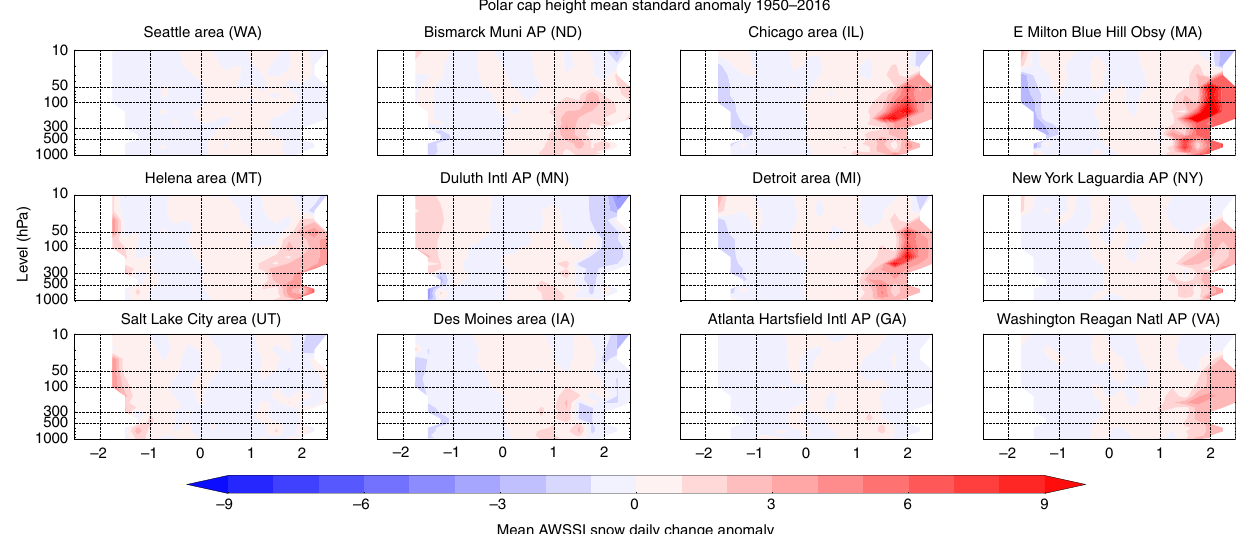
Fig. 4 Warm Arctic related to increased snowfall. Snowfall contribution to the average daily change in the AWSSI at selected weather stations across the US associated with polar cap geopotential height anomalies (PCH) from the surface to the mid-stratosphere (10 hPa) 1950 – 2016. Anomalies computed relative to climatology from 1981 to